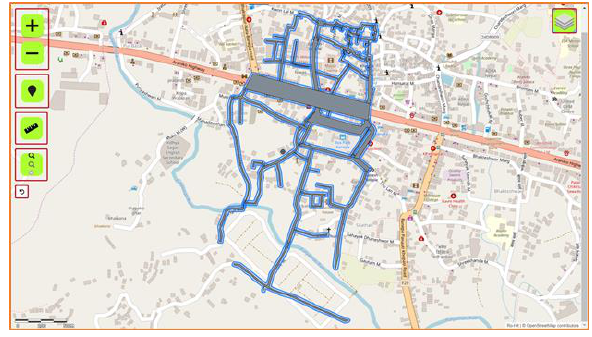
Figure 4. Buffering function applied to transportation